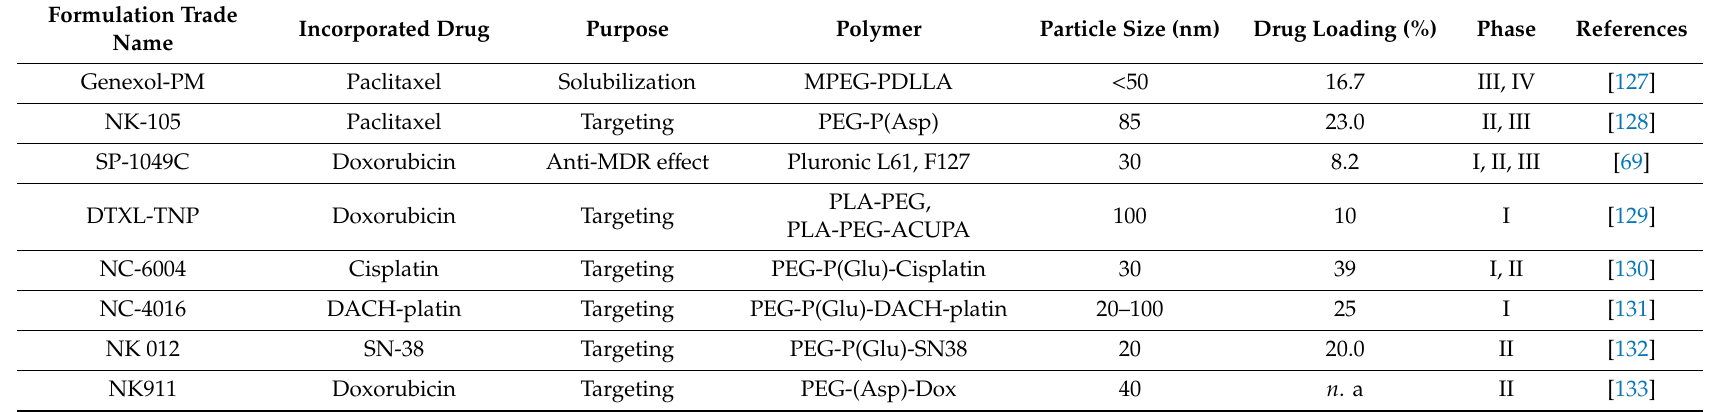
Table 4. Polymeric micelle-based formulations containing chemotherapeutic drugs in clinical